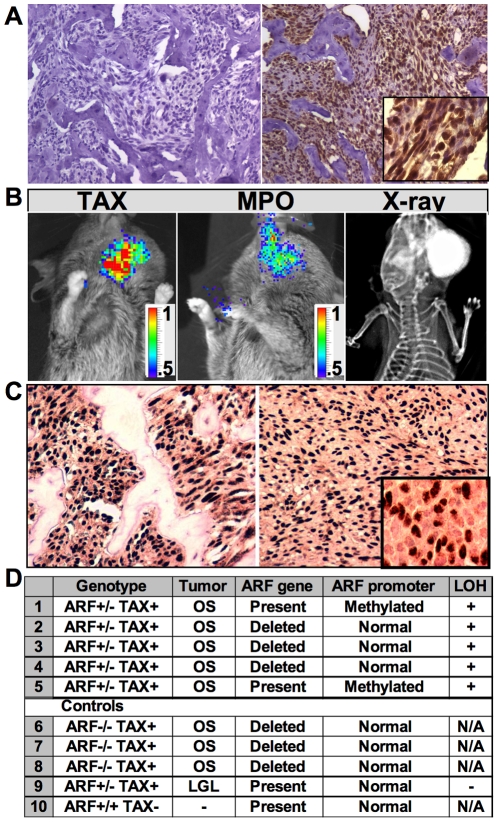
Functional Tax protein and biallelic Arf loss were necessary for osteosarcoma development in Tax+Arf-/- mice.a) Immunohistochemical staining of OS section for Tax (right) compared to isotype control (left). b) In vivo bioluminescence. (Left) HTLV-1 LTR-driven bioluminescent activity as a marker of Tax activity in OS. (Middle) Luminol-based detection of myeloperoxidase (MPO) activity. (Right) Radiograph. Color scale indicated is X104 photons/s/cm2/sr. c) Immunohistochemistry for nucleophosmin (NPM) in primary Tax+Arf-/- OS. 2 representative samples are shown. d) Genetic evaluation of the Arf locus for loss-of-heterozygosity (LOH) in Tax+Arf+/- OS (top panel), control Tax+Arf-/- OS, Tax+Arf-/- large granular lymphocytic (LGL) peripheral tumor and Tax+Arf+/+ tumor-free tail tissue.